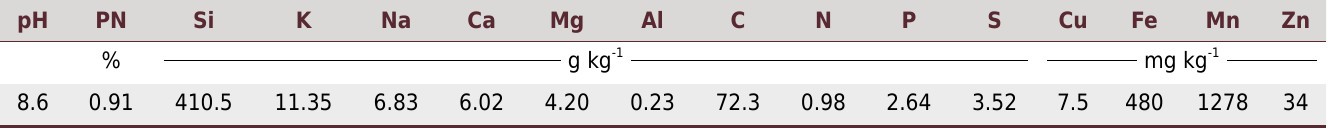
Table 2. Chemical composition of the rice husk ash used in this